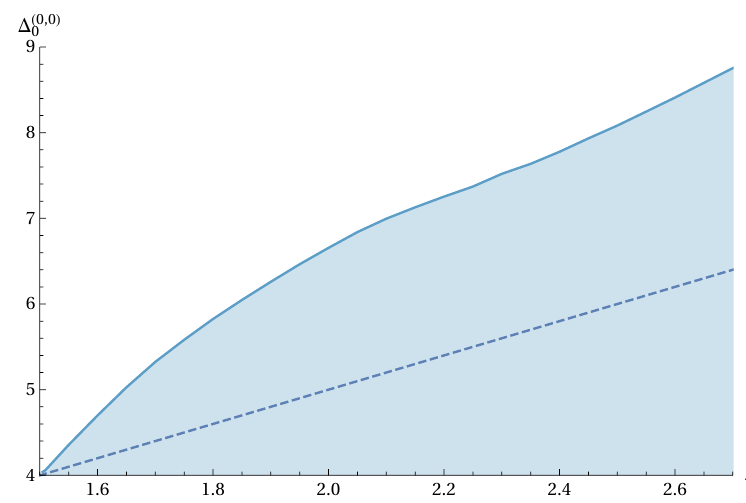
Figure 14 . Upper bound on the (cid:12)rst neutral scalar operator. The shaded region is the allowed one. The bounds has been computed at (cid:3) = 20. The dashed line represents the